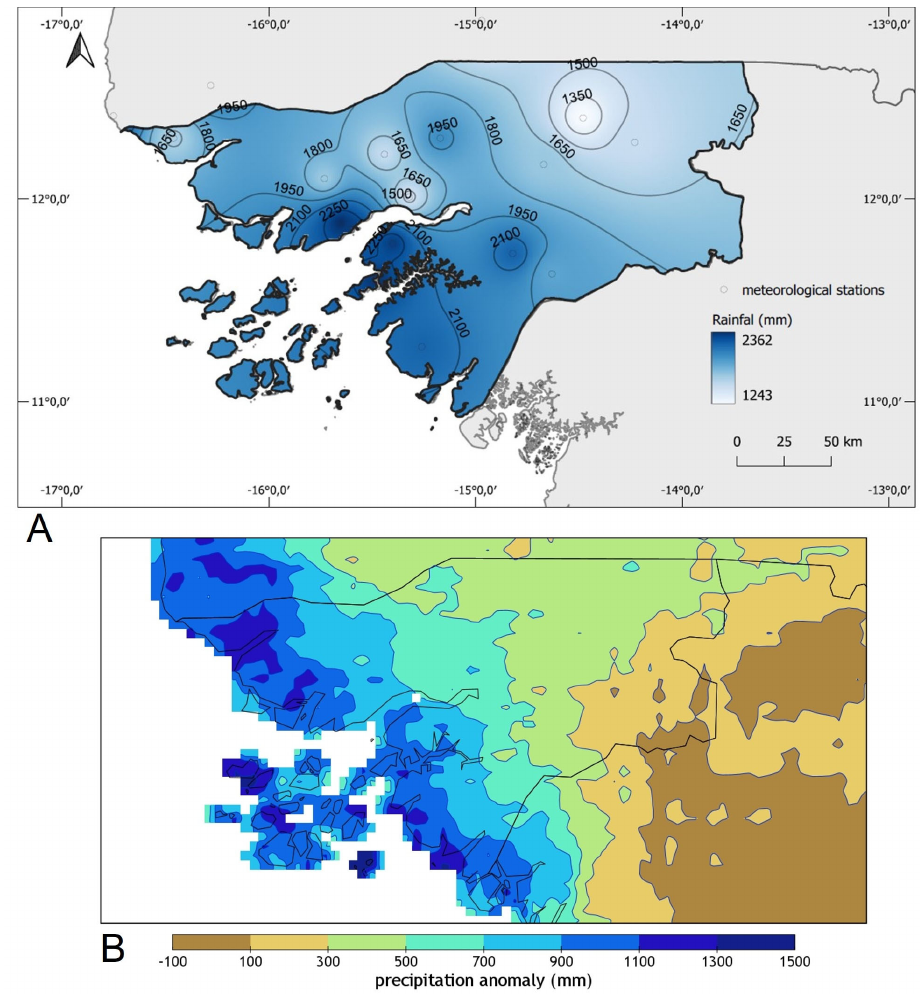
Figure 3. 2020 annual rainfall (mm) in Guinea-Bissau: ( A ) total amount; ( B ) anomaly (annual precipitation in 2020 minus long ‐ term of mean, 1981–2020 baseline reference period). Data source: National Institute of Meteorology of Guinea ‐ Bissau.